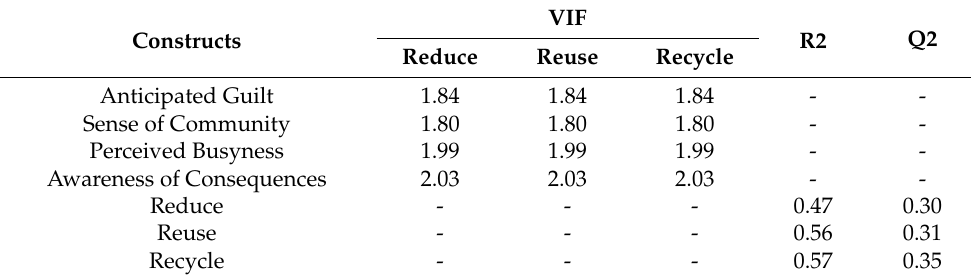
Table 5. Results of Structural Model.